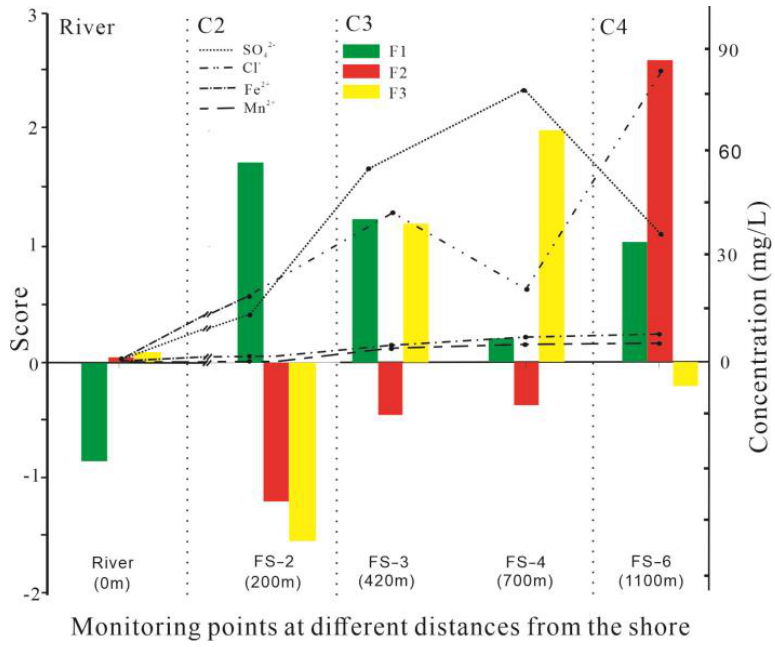
Figure 9. Factor scores and component concentrations in C2, C3 and, C4.